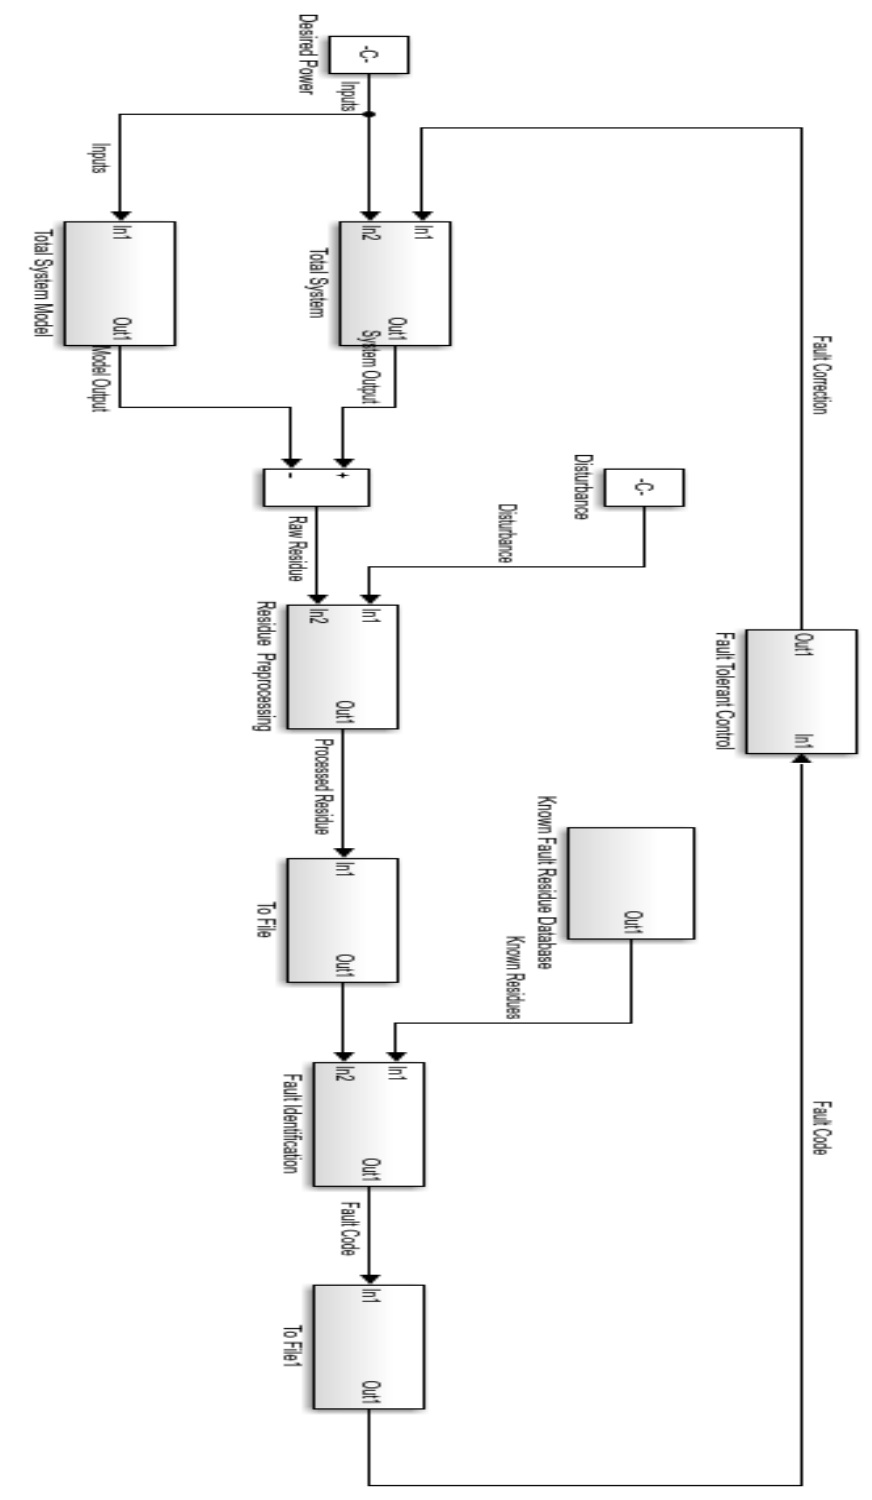
Figure 6. Fault diagnostic scheme.